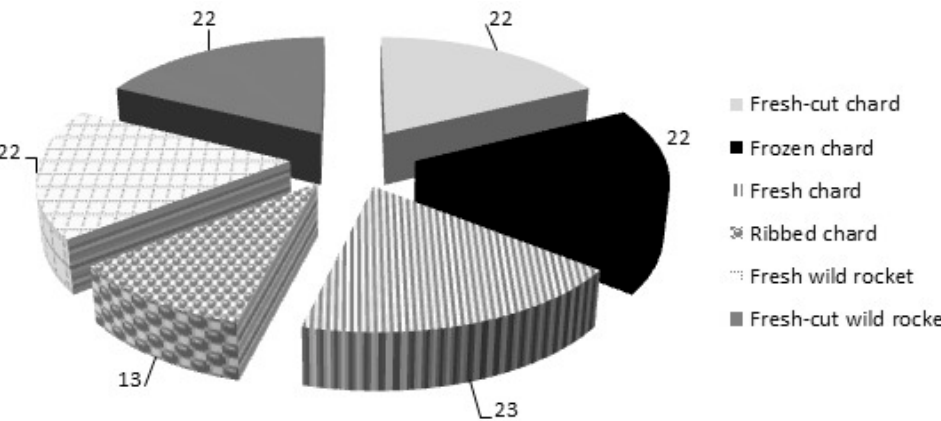
Figure 1. Number and type of samples analysed in this